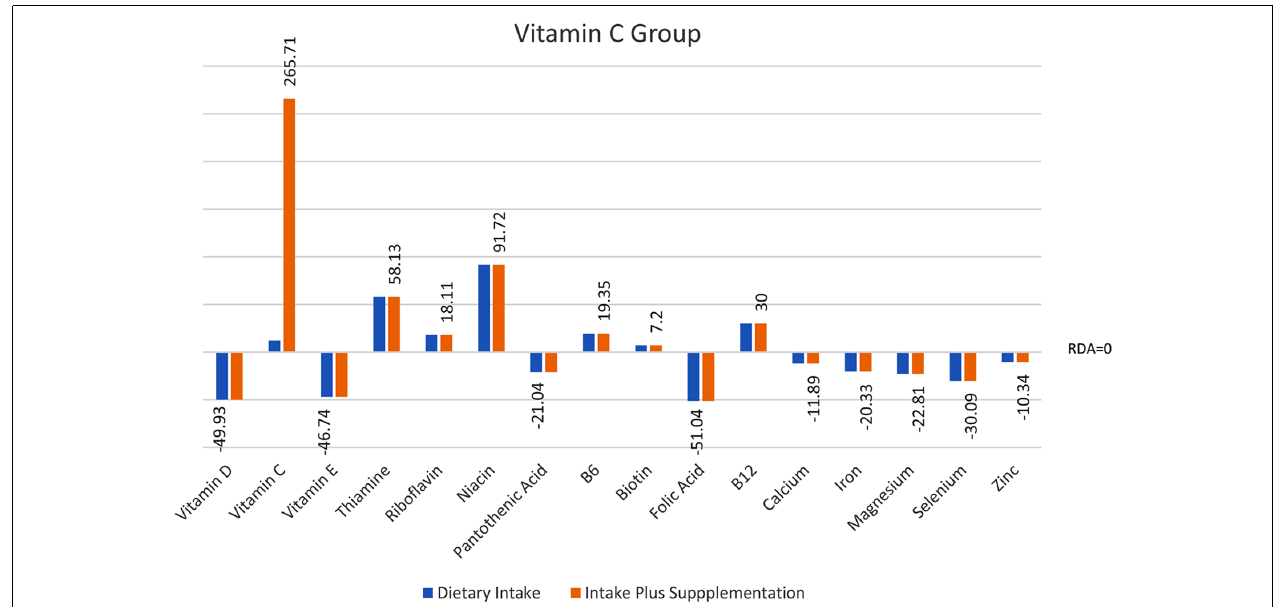
FIGURE 5 | Intake of micronutrients in the Vitamin C group pre- and post-intervention ( n =